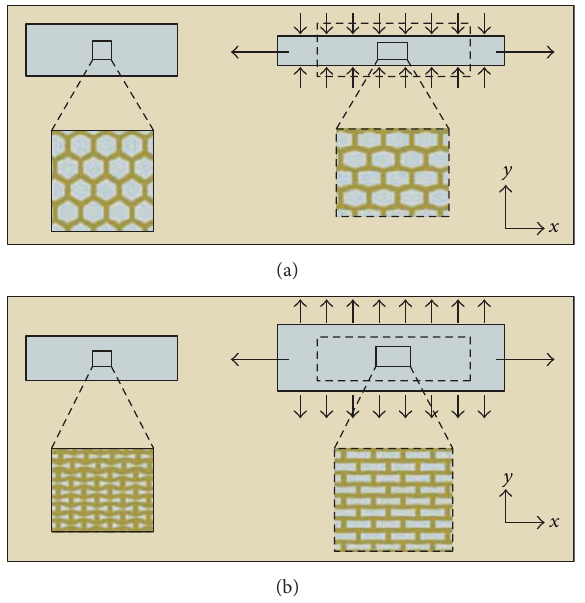
Figure 1: Behaviour of positive Poisson’s ratio and negative Poisson’s ratio when subjected to tensile loading. The pores have a rounder shape (a), while in (b), the pore space is larger, giving rise to a negative Poisson’s ratio [11].